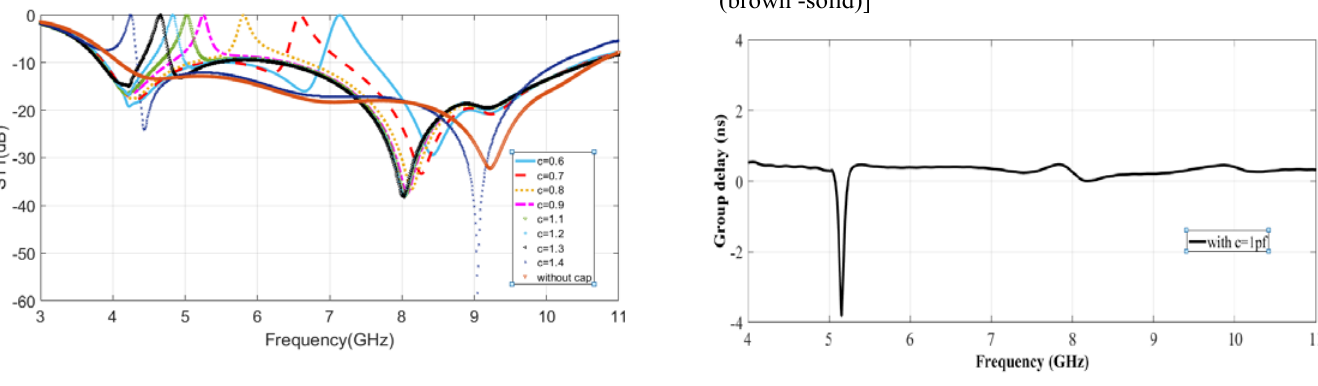
Figure 7: S 11 characteristics of the proposed antenna for different capacitance values in position two